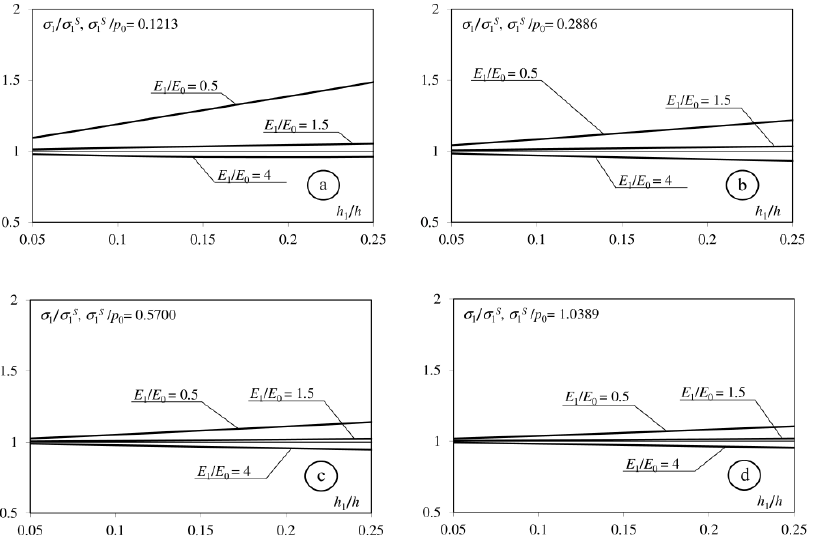
Figure 2. Dependence of the maximum tensile stress on the surface of the considered half-space on the h 1 / h parameters. ( a ): f = 0; ( b ): f = 0.1; ( c ): f = 0.25; ( d ): f = 0.5), h = 0.4; E 2 / E 0 = 2.